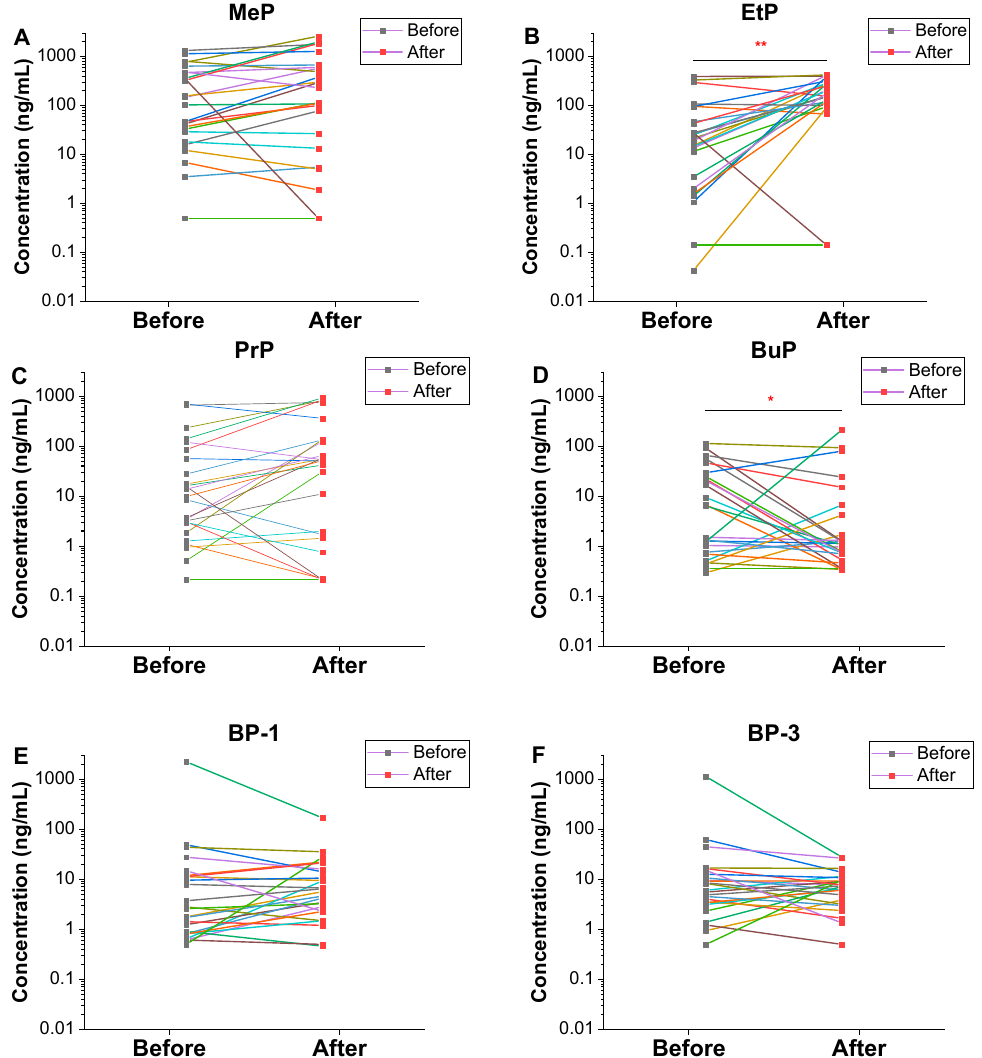
Figure 2. Comparison of urinary paraben and benzophenone concentrations measured before and after the temple stay program for each participant. A : methylparaben, B : ethylparaben, C : propylparaben, D : butylparaben (BuP), E : benzophenone-1 (BP-1), F : benzophenone-3 (BP-3). * Significant differences between before and after the temple stay program ( p < 0.05). ** indicates statistical difference at p < 0.01.